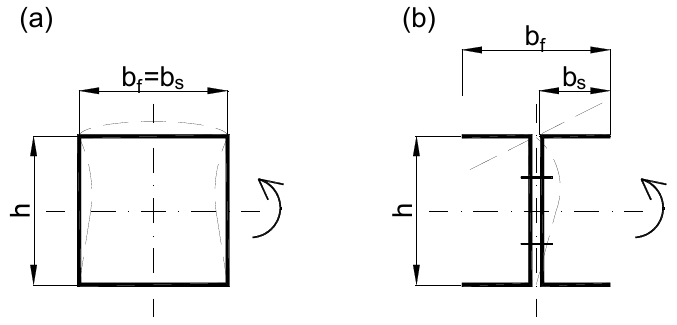
Figure 10. Compared cross-sections of continuous beams: ( a ) box cross-section according to Reference [6], ( b ) compound cross-section type 2C.